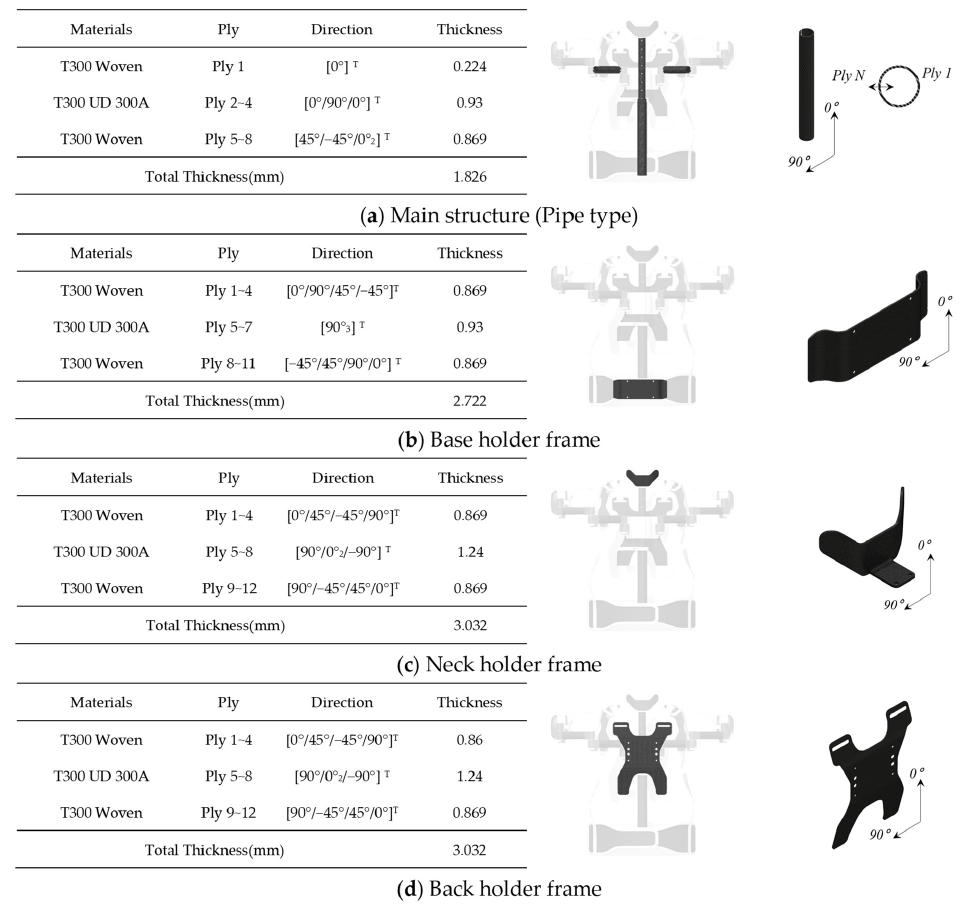
Figure 9. Applied materials and stacking sequence of the lightweight structure: ( a ) pipe type main structure part; ( b ) base holder frame part; ( c ) neck holder frame part; ( d ) back holder frame